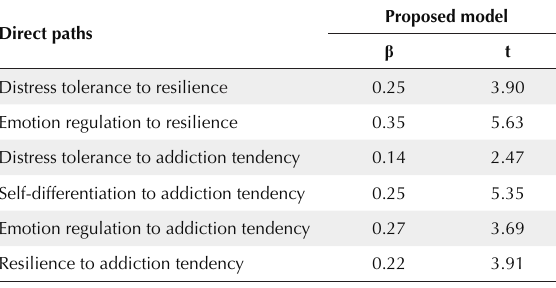
Table 4. Path coefficients of direct effects between research variables in the model Direct